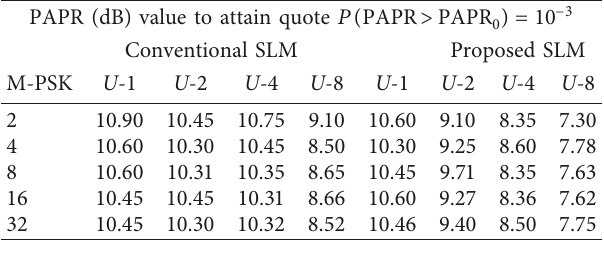
Table 3: CCDF performance investigation of conventional SLM and proposed SLM for N � 128, M-PSK , and U � 1, 2, 4, and